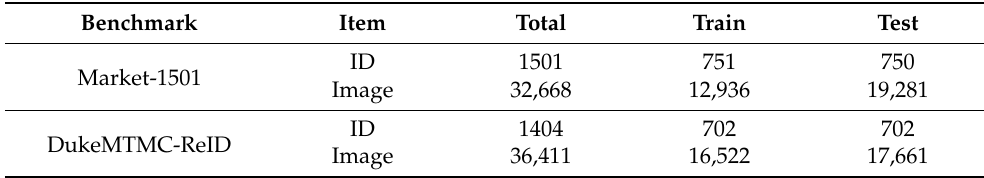
Table 1. Person Re-ID datasets